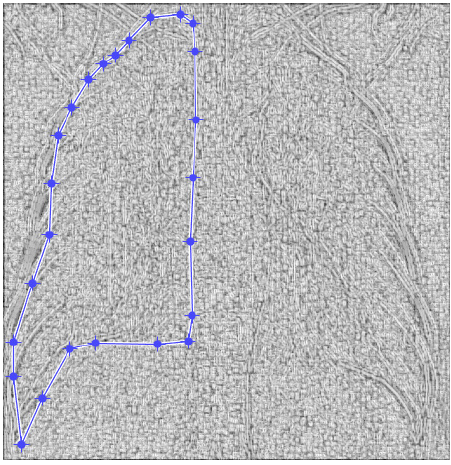
Figure 13. The image from Figure 12 in “Invert color” format. Figures 14 and 15 present the de fi ned masks for the left lung and right lung, framed in blue borders.